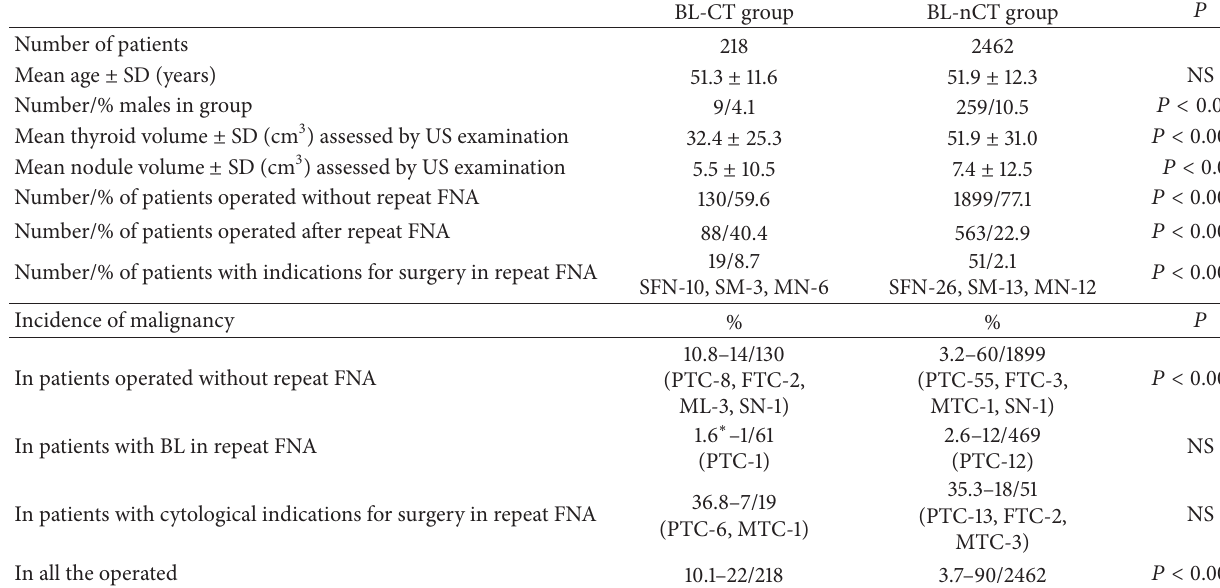
Table 2: Characteristics of the patients treated surgically and the incidence of malignancy revealed in postoperative histopathological examination in BL-CT and BL-nCT